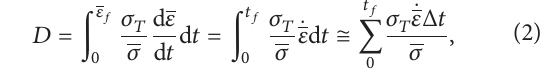
Figure 3: The basic FE model of compression testing in